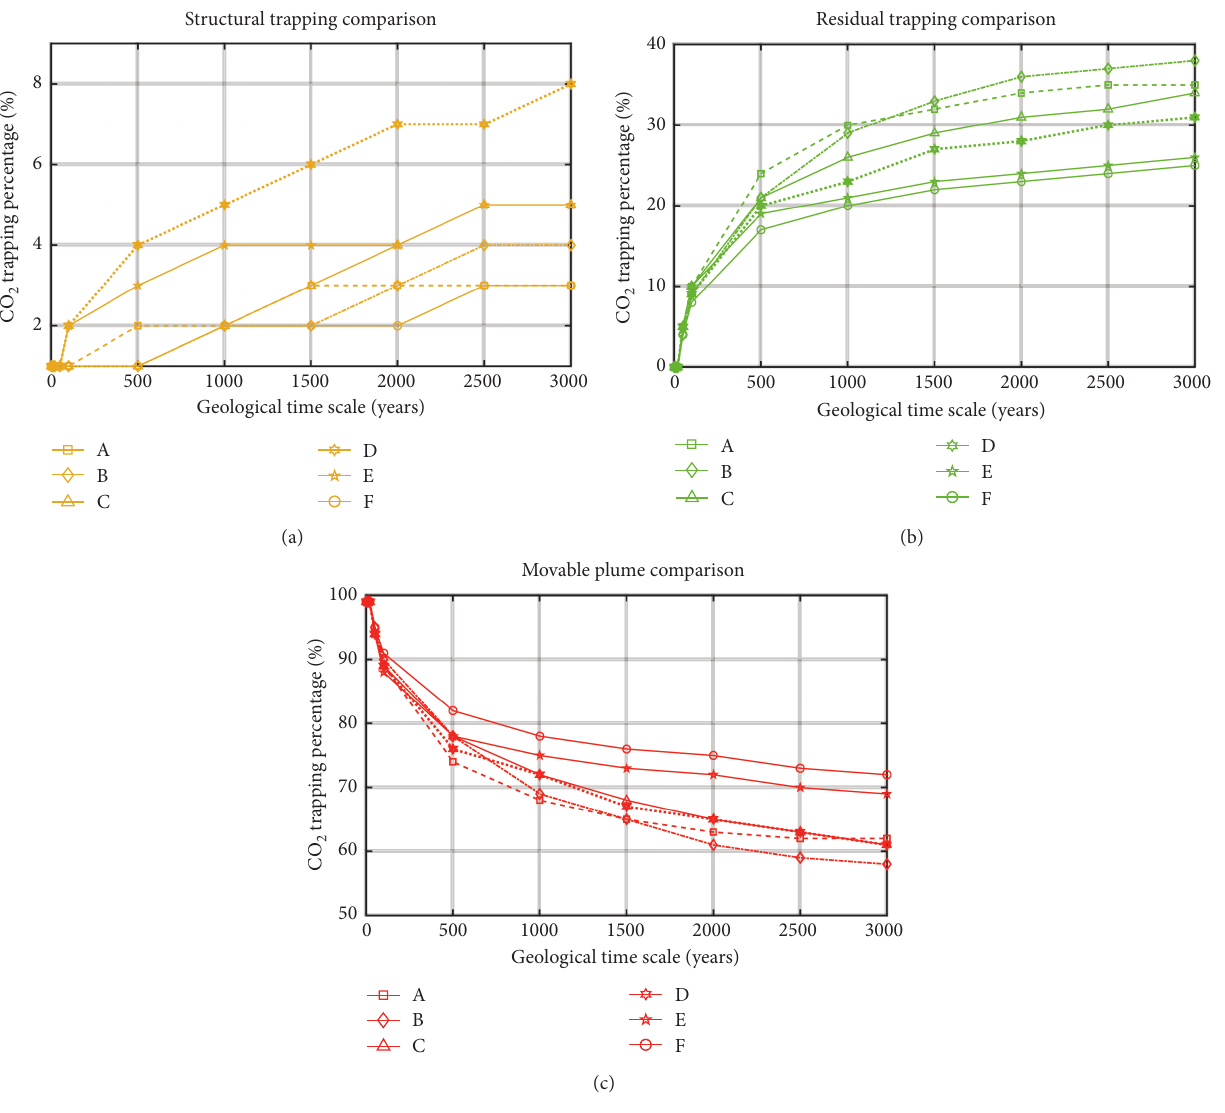
Figure 5: Dynamic evolution of structural trapping and residual trapping when CO geological